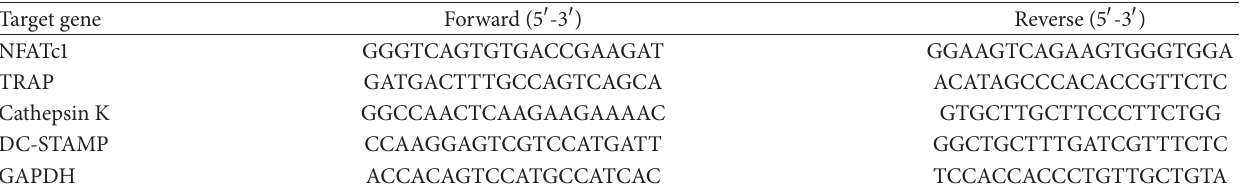
Table 1: Primer sequences used in this study.